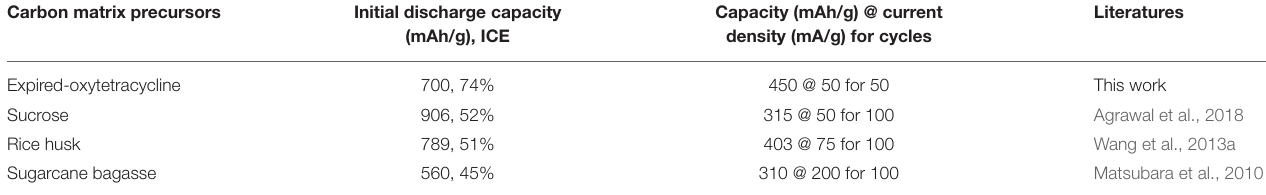
TABLE 2 | The comparison of performances of expired-oxytetracycline-derived carbon with those of other precursors-based carbon anode in literatures.